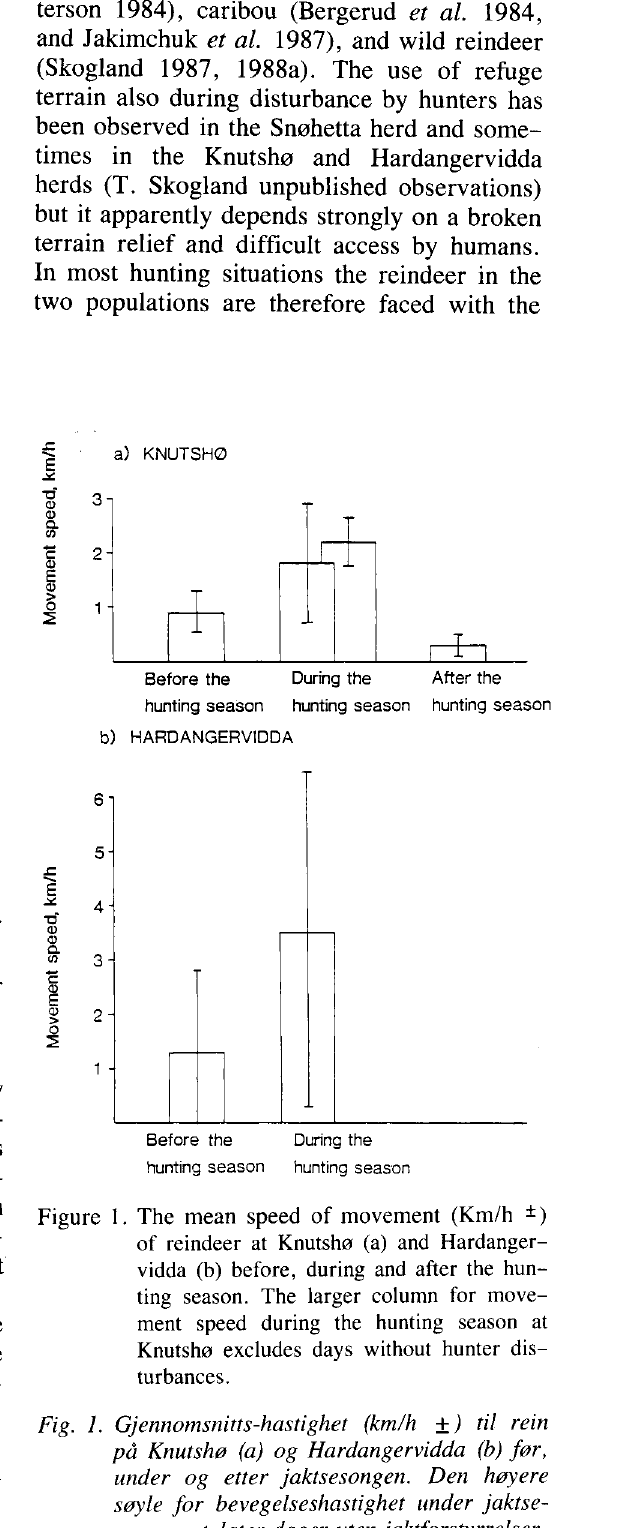
Figure 1. The mean speed of movement (Km/h ±) of reindeer at Knutshø (a) and Hardanger vidda (b) before, during and after the hun ting season. The larger column for move ment speed during the hunting season at Knutshø excludes days without hunter dis turbances. Fig. 1. Gjennomsnitts-hastighet (km/h ±) til rein på Knutshø (a) og Hardangervidda (b) før, under og etter jaktsesongen. Den høyere søyle for bevegelseshastighet under jaktse songen utelater dager uten